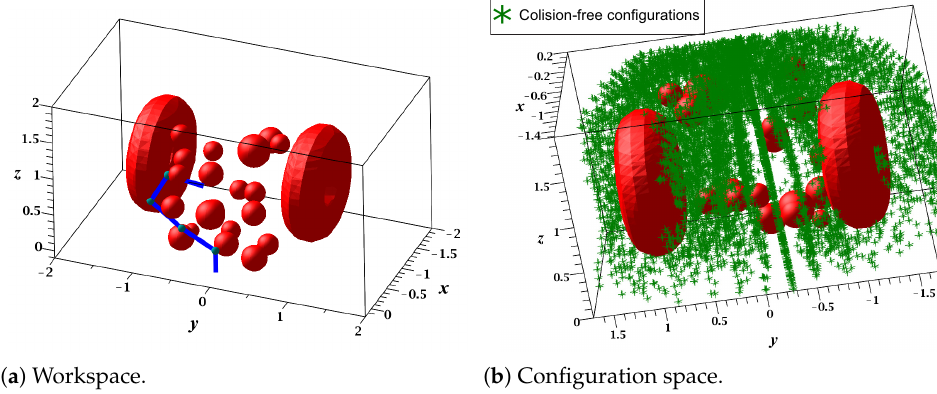
Figure 14. Workspace and configuration space of the five-DOF manipulator). Table 5. D-H parameters of the 5 DOF